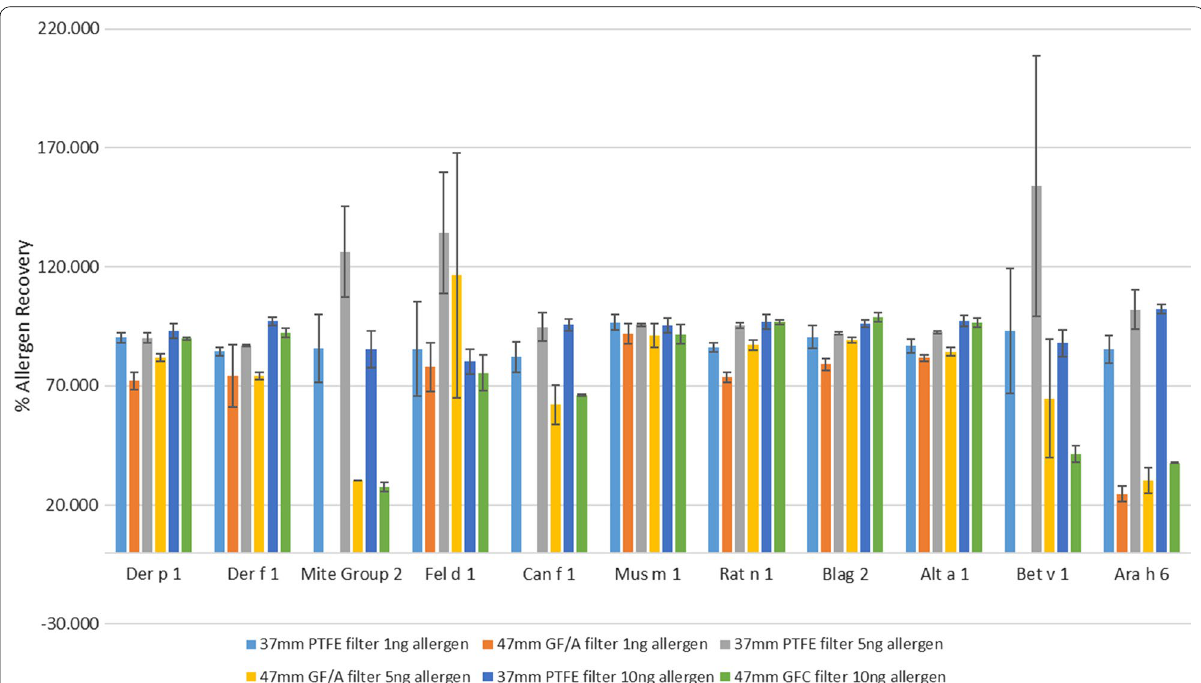
Fig. 1 Percentage allergen recoveries (versus the no filter control samples)—a comparison of PTFE and GF/A filters incubated with 1, 5 or 10 ng allergen for 2 h. Average values with standard